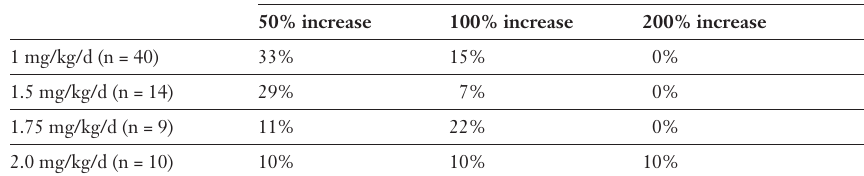
Table 3 Creatinine concentra- tion (percent increase of baseline) under conventional ampho- tericin B continuous infusion to reduce nephrotoxicity (adapted from Imhof et al.